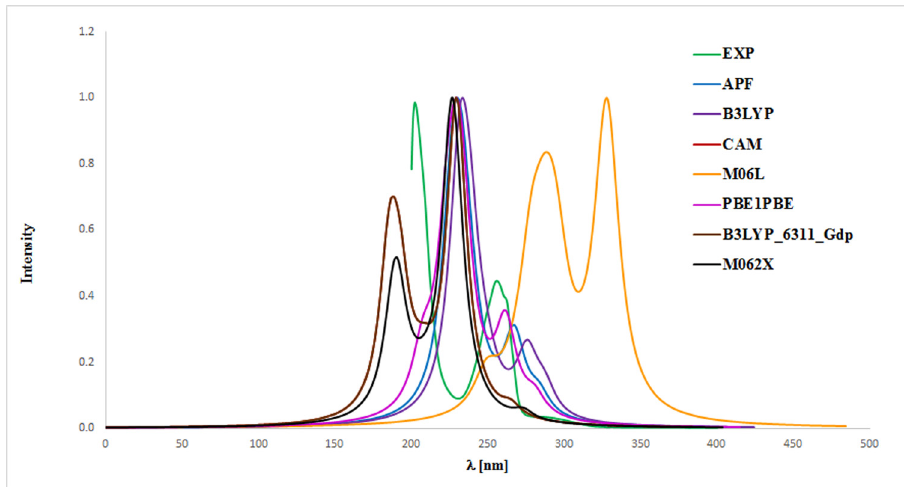
Figure 6: Experimental ( EXP ) and theoretical UV - vis spectra of voriconazole 1 registered in methanol and computed using CPCM solvation model ( methanol as solvent ) ; approximations: APF – APF/6 - 311 ++ G ( 2d,3p ) //APF/6 - 31G ( d,p ) , B3LYP – B3LYP/6 - 311 ++ G ( 2d,3p ) //B3LYP/6 - 31G ( d,p ) , CAM – CAM - B3LYP/6 - 311 ++ G ( 2d,3p ) //CAM - B3LYP/6 - 31G ( d,p ) , M06L – M06L/6 - 311 ++ G ( 2d,3p ) //M06L/6 - 31G ( d,p ) , M062X – M062X/6 - 311 ++ G ( 2d,3p ) //M062X/6 - 31G ( d,p ) , PBE1PBE – PBE1PBE/6 - 311 ++ G ( 2d,3p ) //B3LYP/6 - 31G ( d,p ) , and B3LYP_6311_Gdp – B3LYP/6 - 311 ++ G ( 2d,3p ) //B3LYP/6 - 311 ++ G ( d,p )